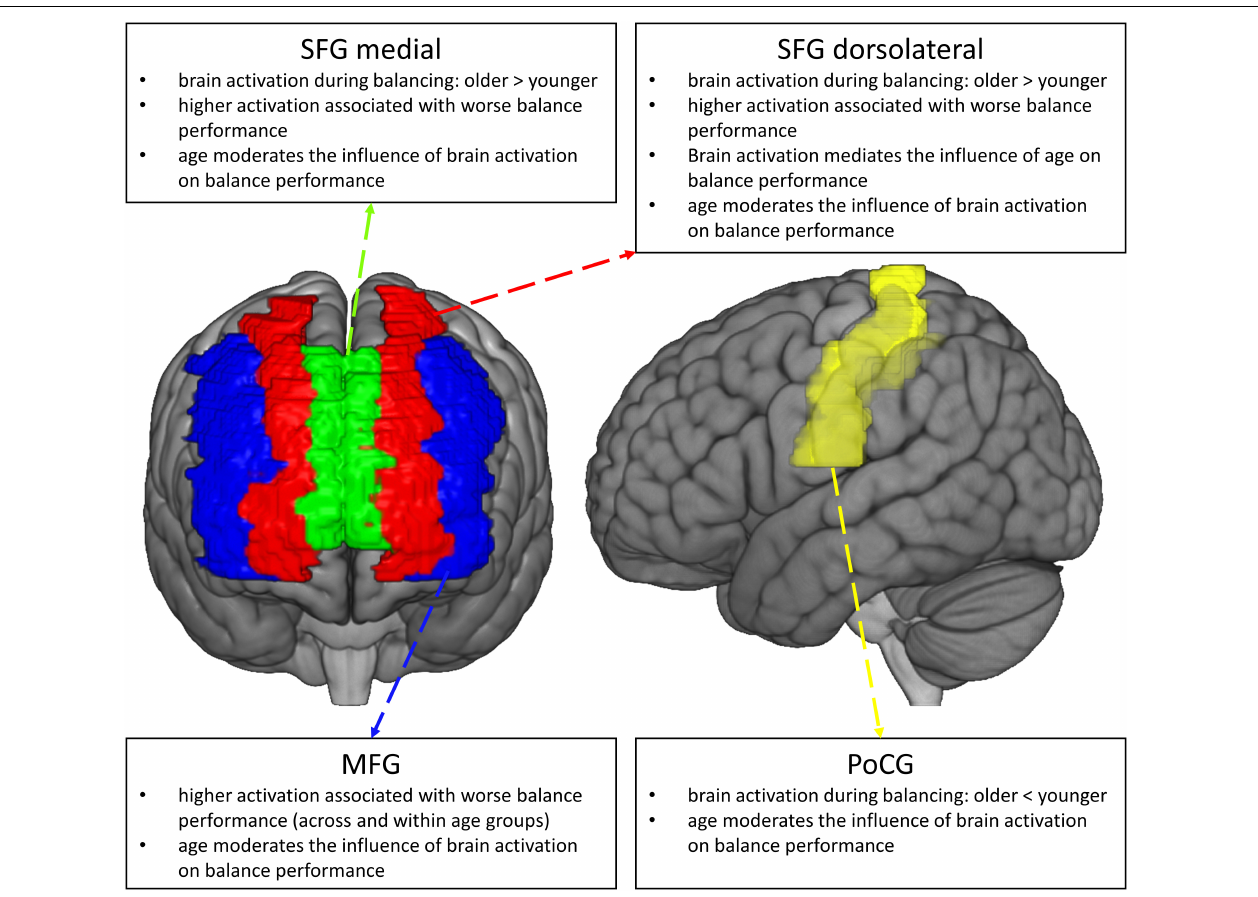
FIGURE 8 | Graphical summary of the main results of the